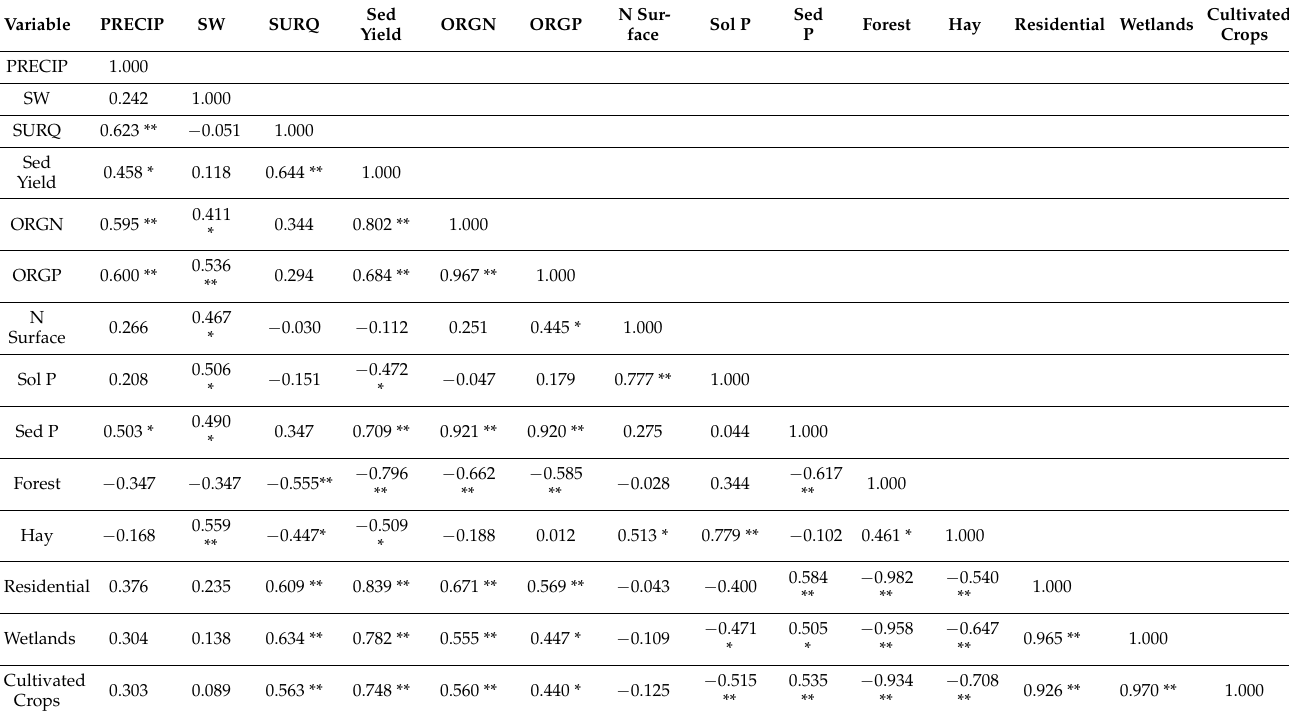
Table 6. Correlation matrix for key model